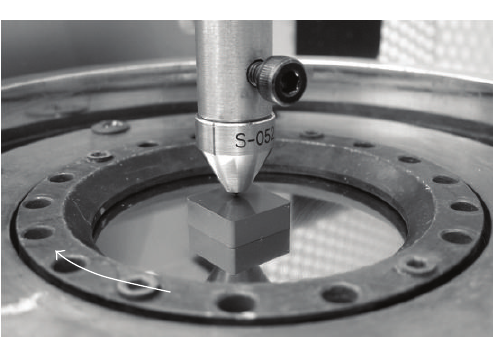
Figure 1: Instrumental test set-up used in the present study. The arrow indicates the rotating